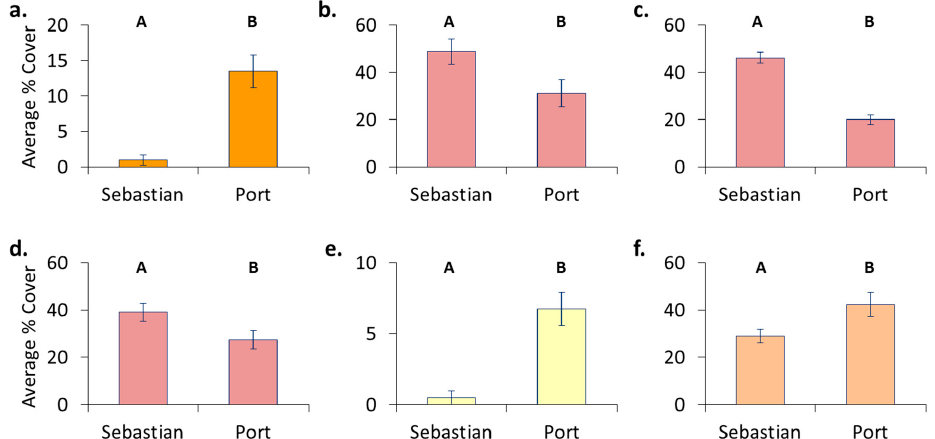
Figure 10. Differences in fouling due to prior location. ( a ) Cover of encrusting bryozoans in Sebastian on Groomed IS700 in August was lower on panels from Sebastian than on those that came from Port Canaveral ( p = 0.002). ( b ) Cover of barnacles in Port Canaveral on IS700 in August was higher on panels from Sebastian than on those from Port Canaveral ( p = 0.038). ( c ) Cover of barnacles in Port Canaveral on cleaned IS900 in August was higher on panels from Sebastian than on those from Port Canaveral ( p < 0.001). ( d ) Cover of barnacles in Port Canaveral on DC3140 in August was higher on panels from Sebastian than on those from Port Canaveral ( p = 0.042). ( e ) Cover of sponges in Port Canaveral on cleaned IS700 in September was lower on panels from Sebastian than on those from Port Canaveral ( p = 0.012). ( f ) Cover of tunicates in Port Canaveral on IS900 in August was lower on panels from Sebastian than on those from Port Canaveral ( p = 0.033). The X-axes are treatments; the Y-axes are average percent cover. Please note the Y-axes differ. Letters above the bars denote statistical significance (i.e., As are statistically similar to, but significantly different than, Bs).